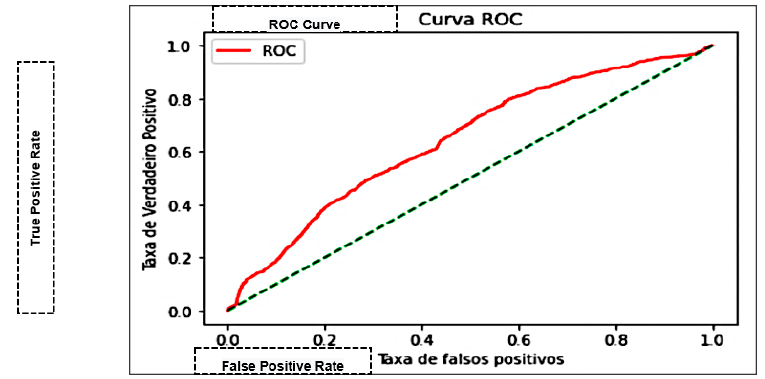
Figure 6. ROC curve—multinomial.